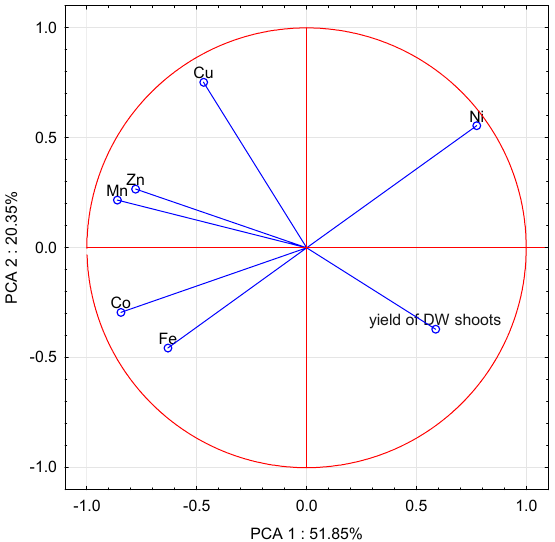
Figure 2. Yield of dry weight (DW) shoots and concentration of trace elements in shoots of maize ( Zea mays L.) illustrated with the principal component analysis (PCA) method. Results of PCA performed with yield of DW shoots and concentration of Cu, Zn, Ni, Mn, Fe and Co in shoots of Table 5. Correlation coefficients (r) between yield of DW shoots, concentration of trace elements in shoots of maize ( Zea mays L.) and concentration of trace elements and some other properties of soil.